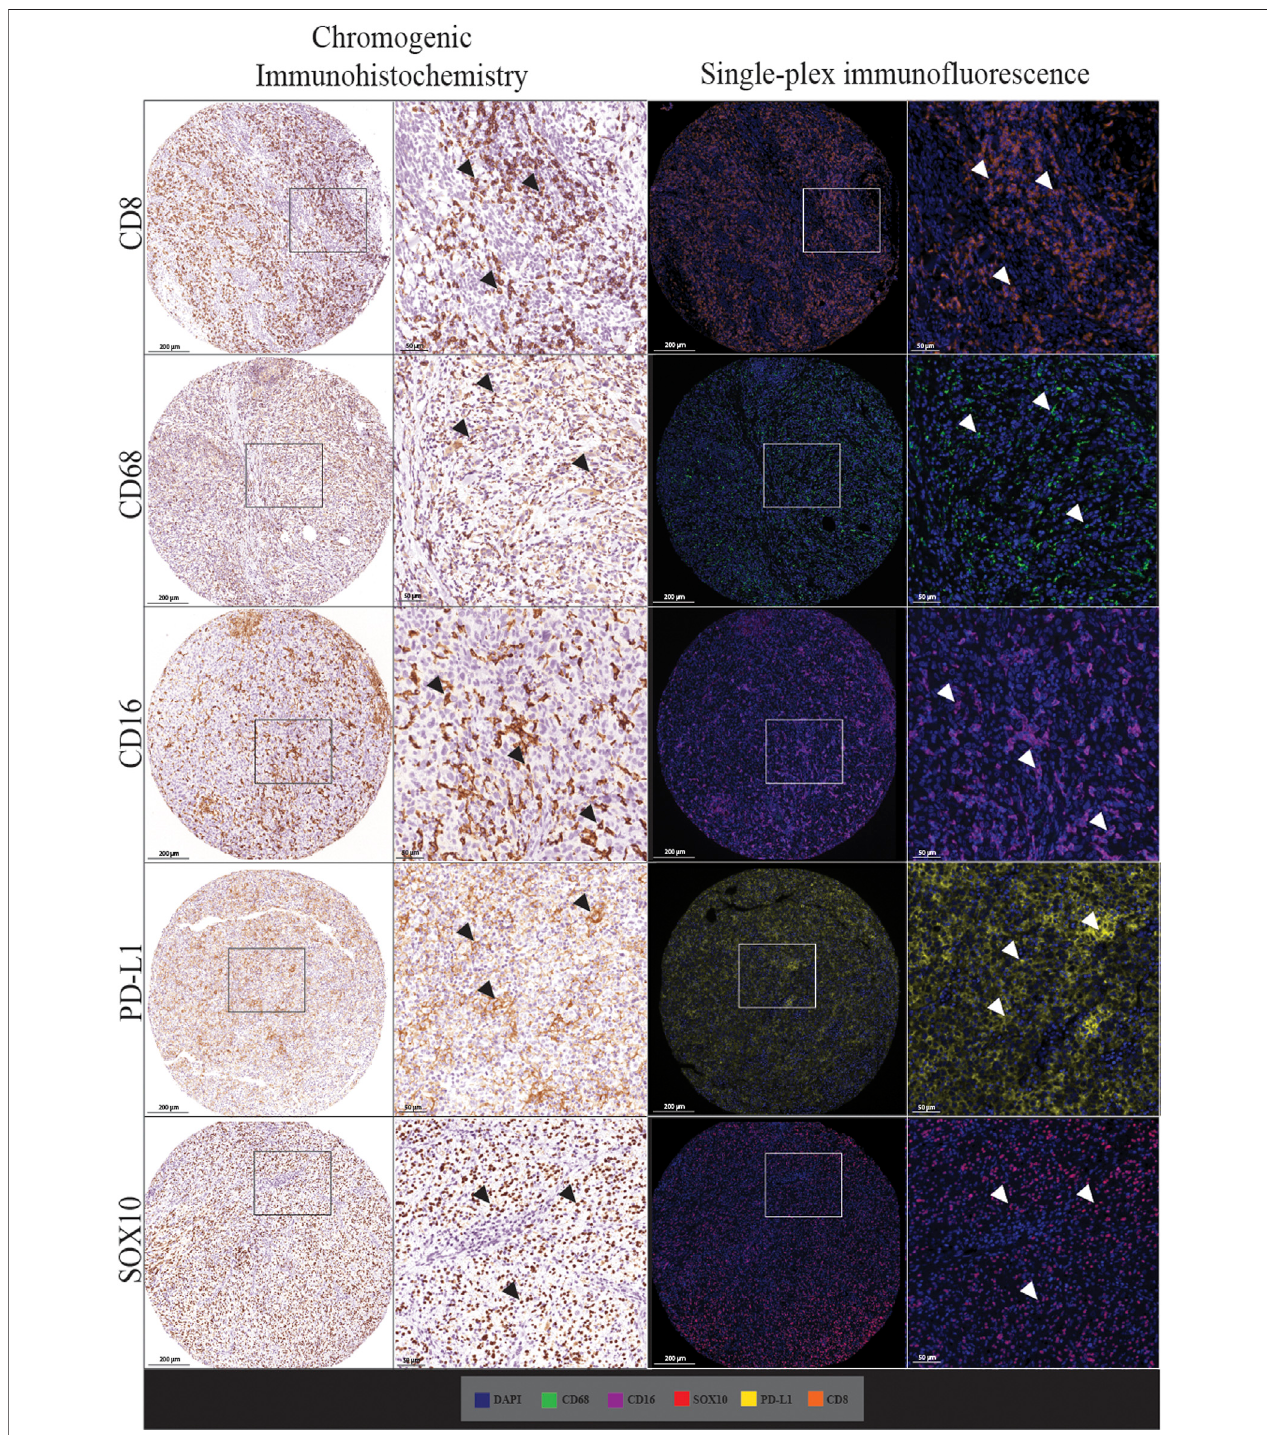
FIGURE 2 | Microphotographs of representative examples of staining with traditional chromogenic immunohistochemistry (left panels) and single-plex immuno fl uorescence (right panels) along with corresponding 20× sample regions from the same patient core for each marker. White arrows indicate positive staining. Antibodies stained using traditional chromogenic IHC and single-plex immuno fl uorescence show similar patterns of expression. Scale bars are 200 and 50 µm for the low-magni fi cation (×7.5) and high magni fi cation (×20) microphotographs respectively.